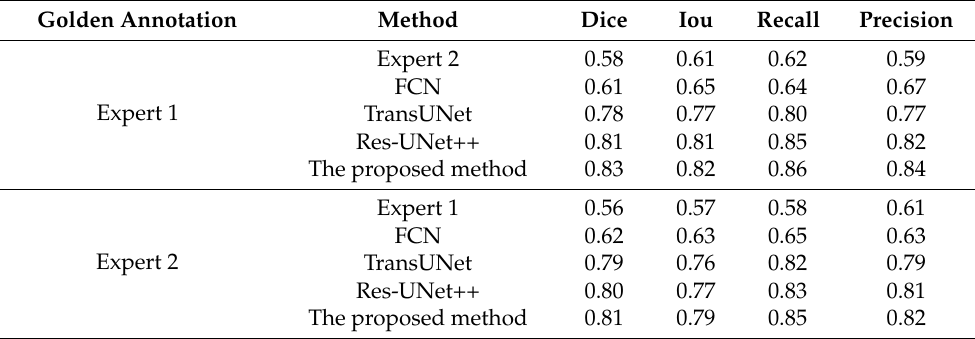
Table 2. Comparison of test results of different methods in macular edema OCT images with multi- scale and